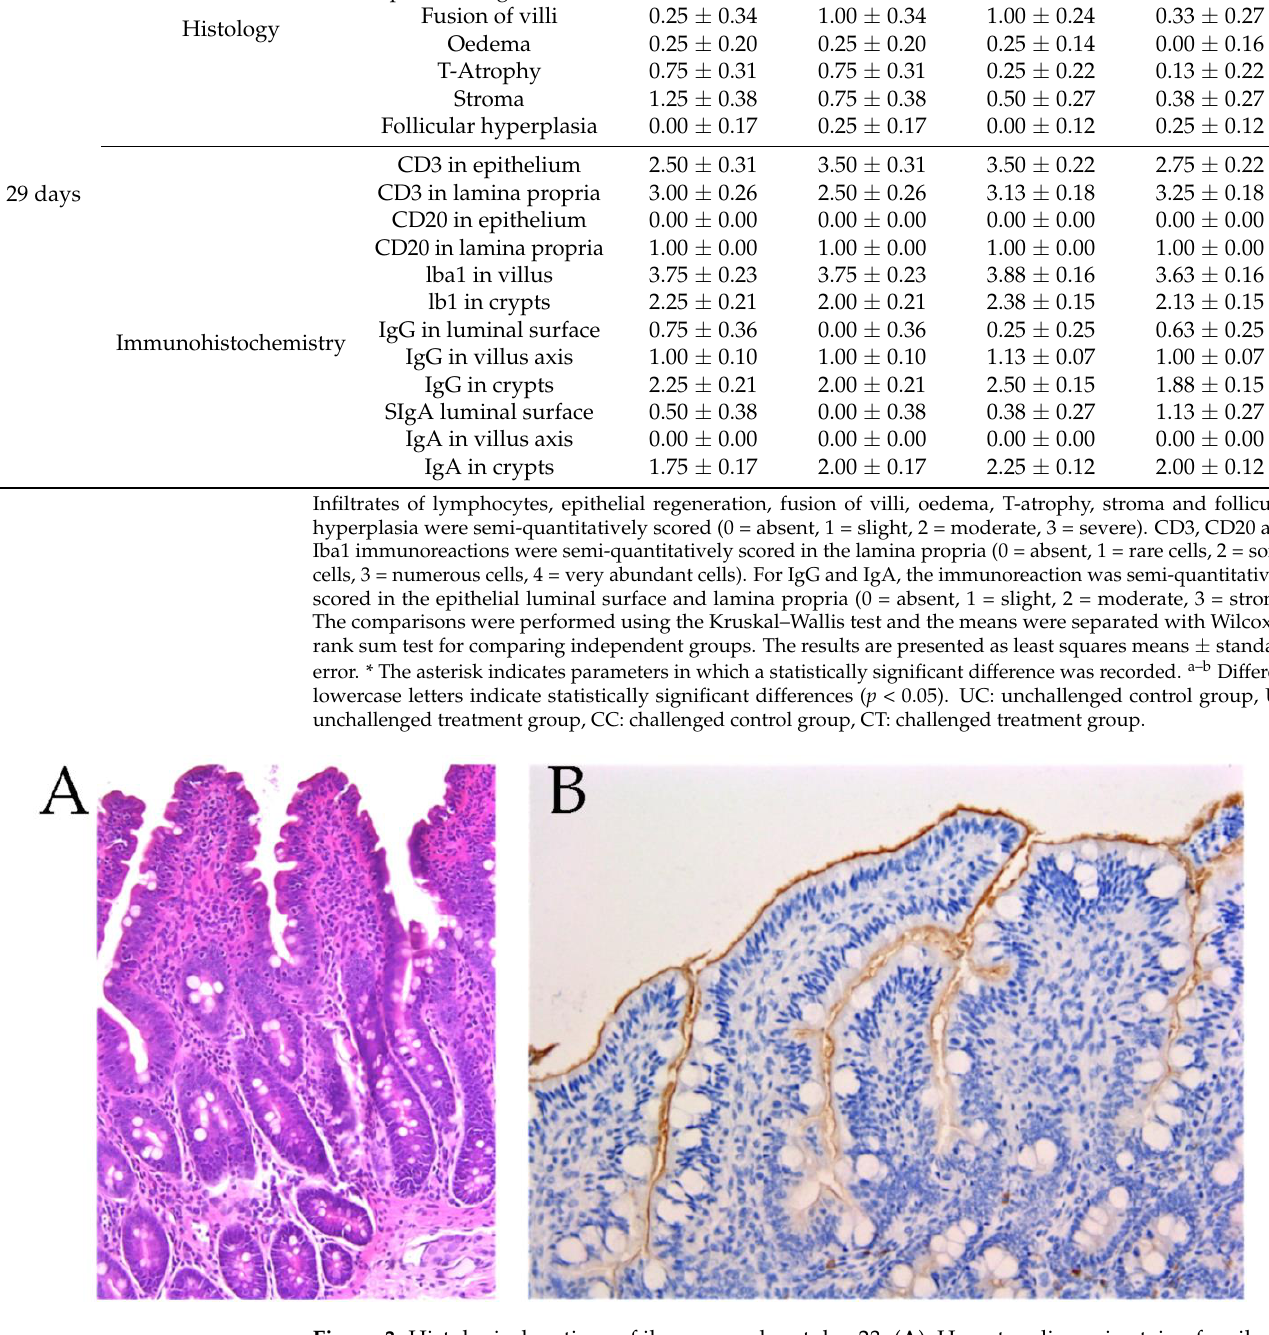
Figure 3. Histological sections of ileum samples at day 23. ( A ): Hematoxylin eosin stain of an ileum section of the challenged control group (CC), 200×. The presence of numerous inflammatory cells (lymphocytes, histiocytes, eosinophils) in the lamina propria of villi. ( B ): Immunohistochemistry for IgA in an ileum section of the unchallenged tobacco vaccinated group (UT), 200×. A positive signal of the presence of IgA is localized on the luminal surface of the enterocytes.